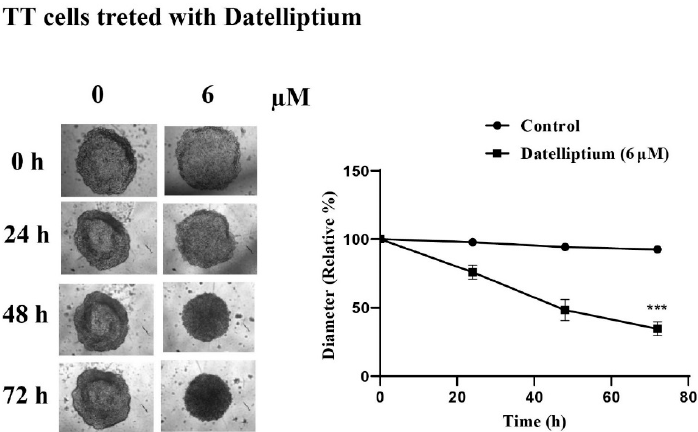
Figure 4. Effect of datelliptium on the growth of spheroids from TT cells. Spheroids were